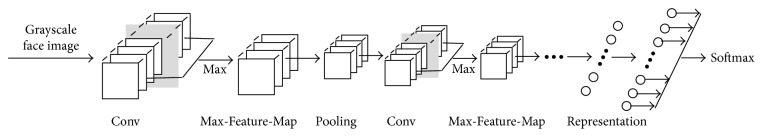
The architecture of the lightened CNN.